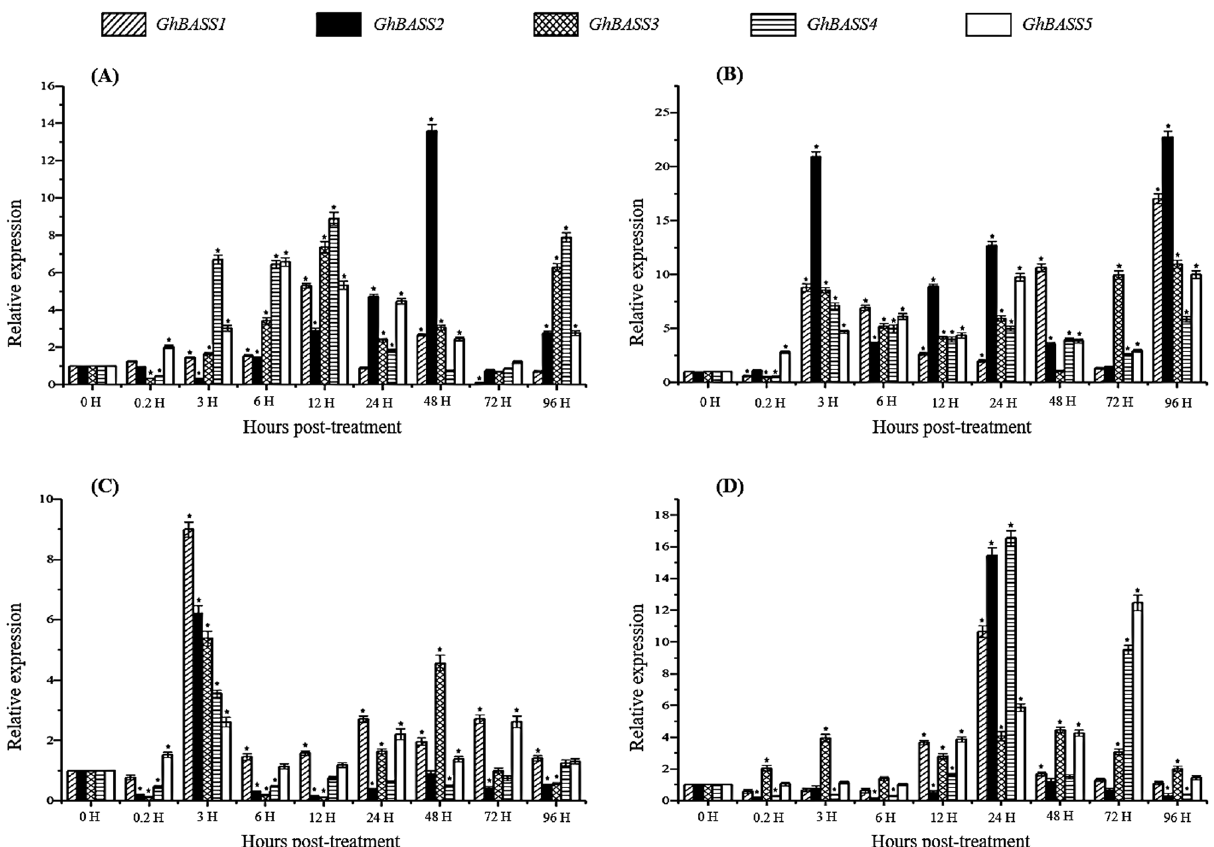
Figure 8. Expression patterns of GhBASSs during the treatments of various phytohormones. ( A ) Expression levels of GhBASSs in cotton leaves responded to the methyl viologen (MV) treatment. ( B ) Expression profiles of GhBASSs in cotton leaves after treated with abscisic acid (ABA). ( C ) Transcript levels of GhBASSs in cotton leaves against salicylic acids (SA). ( D ) Expression patterns of GhBASSs in cotton leaves exposed to gibberellic acids (GA3). Expression levels were analyzed by qPCR and normalized to the GhUBQ7 gene (GenBank accession no. DQ116441). Means and standard deviations were based on three independent biological replicates. Error bars represent the variation among three independent biological replications. Asterisks indicate the significant difference ( * , P = 0.05) from 0 hpt by Tukey’s HSD leaves and weakened roots in comparison with mutants and WT, in spite of the fact that their shoot and root performances were similar under normal situations (Fig. 11A,C). For further clarification of salt sensitivity of soil-grown GhBASS2 -OE and GhBASS5 -OE lines, 3-week-old WT, mutants and transgenic plants were irrigated with 150 mM NaCl. After 7 days of the salt treatment, GhBASS2 -OE and GhBASS5 -OE plants showed more impaired phenotypes with chlorotic and wilting leaves when compared with the control plants. Nonetheless, they had much better phenotypes displaying deeper green leaves than those of the controls once exposed to the non-salt treatment (Fig. 11B). To verify the phenotype results, a direct investigation of ion levels in tissues was demanded. Before NaCl treat- ment, Na + contents of tested plants were not clearly different (WT = 2.77 ± 0.11 mg g -1 , atbass2 = 2.63 ± 0.31 mg g -1 , treatment, the mean values of Na + contents of the tested plants were distinctly varied (8.54 ± 0.45 mg g -1 from OE2; Mean ± SD for n = 3) (Fig. 12A). On the other hand, the average K + concentration of OE plants was always lower than those of WT and mutants under both conditions (WT = 20.14 ± 0.8 mg g -1 , atbass2 = 20.5 ± 0.8 mg g -1 ,